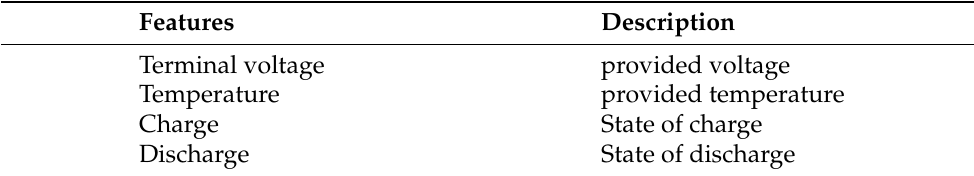
Table 4. Features extraction.